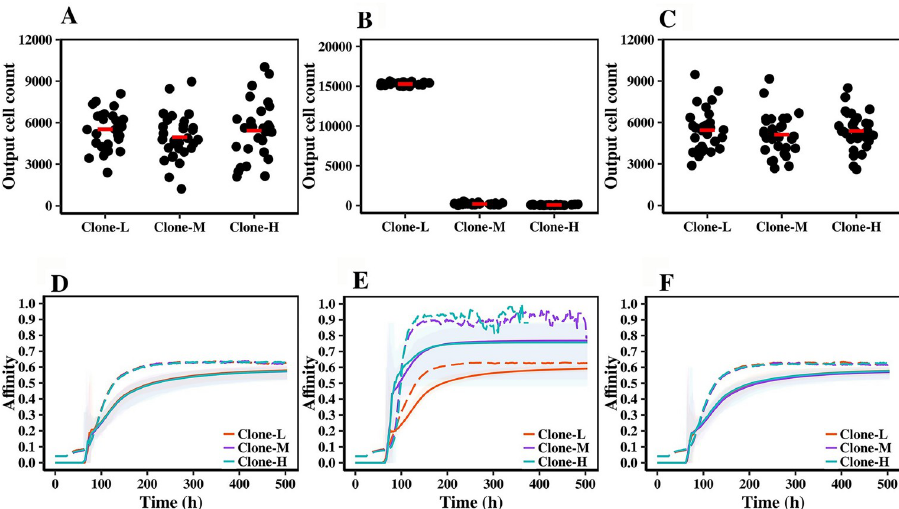
Fig 4. OCs production and affinity maturation. Results are obtained from 30 simulations. (A), (B) and (C) represent produced OCs from each clone in the reference scenario, Scenario-1 and Scenario-2, respectively. Each dot represents OCs produced in a single simulation. Red lines denote the average. (D), (E) and (F) represent the average affinity of living GC B cells (dashed lines) and the cumulative average of produced OCs (solid lines) belonging to each clone in the reference scenario, Scenario-1 and Scenario-2, respectively. Shaded areas indicate the maximum and minimum of OC’s average affinity in 30 simulations.